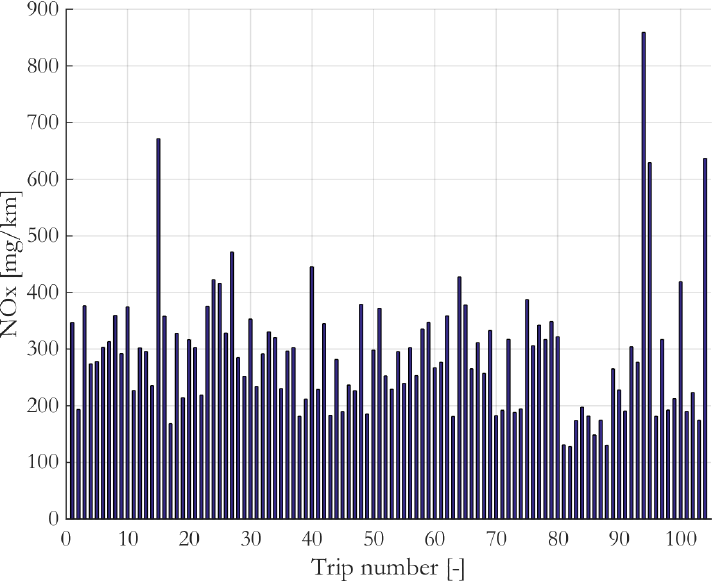
Figure 11. Example of NO x sensitivity on a sample of 104 trips, with the same driver and same vehicle (Diesel